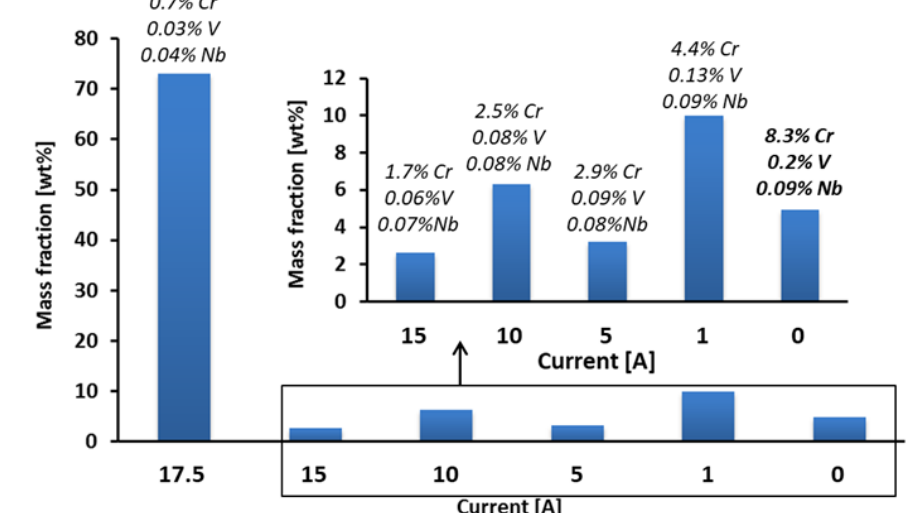
Figure 3. Results of the sequential WHIMSe separation for SS slag.